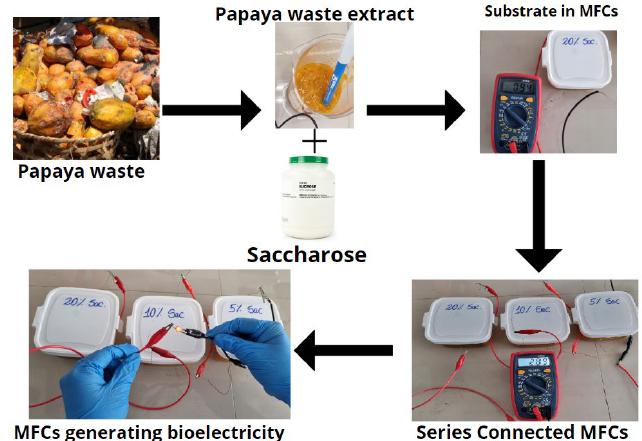
Figure 6. Electricity production in the MFCs.